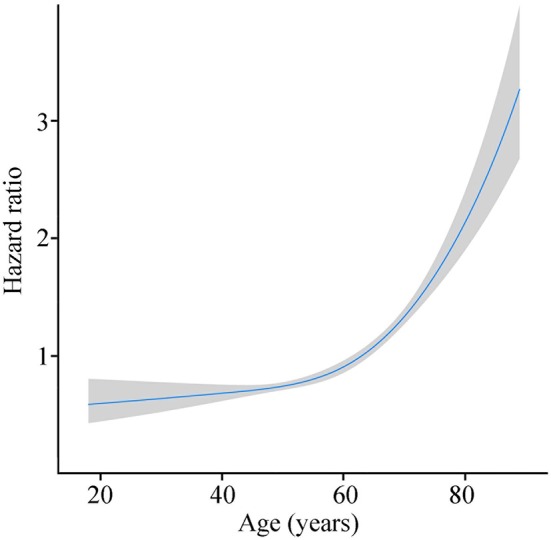
Risk of death with age growing by R software (blue line stands for HR and gray area for 95% CI).